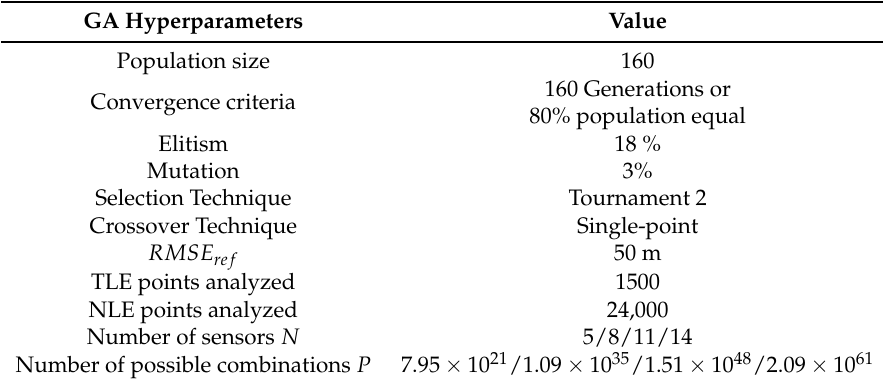
Table 2. GA hyperparameters selected [30]. The resulting number of possible combinations P , obtained from Equation (2), shows the magnitude of the solution environment for the scenario proposed. Due to the number of possible solutions, the application of heuristic methodologies is in order.